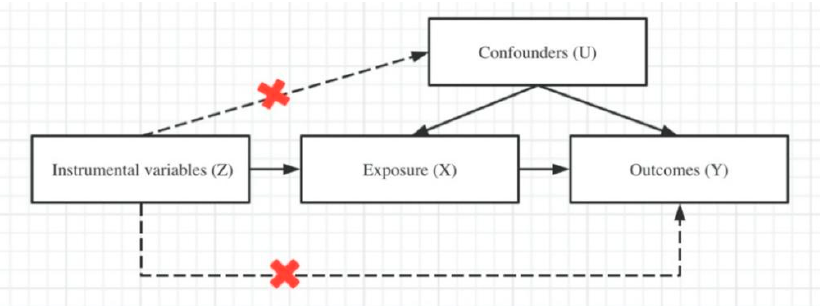
Figure 1. The framework of Mendelian randomization analysis and key assumptions.